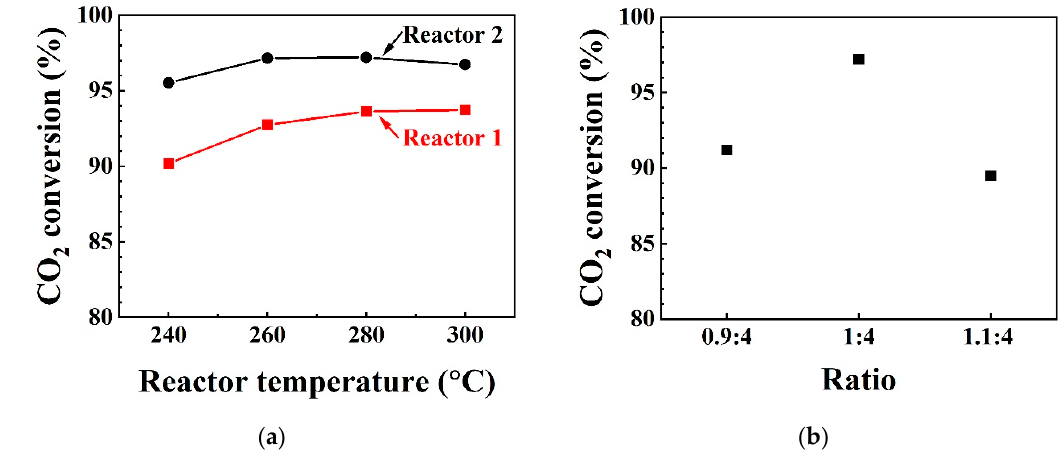
Figure 4. ( a ) Effect of reactor temperature on concentration of methane and ( b ) effect of ratio (CO 2 :H 2 ) Figure 4. ( a ) E ff ect of reactor temperature on concentration of methane and ( b ) e ff ect of ratio (CO 2 :H 2 ) on CO 2 conversion to CH 4 . on CO 2 conversion to CH 4